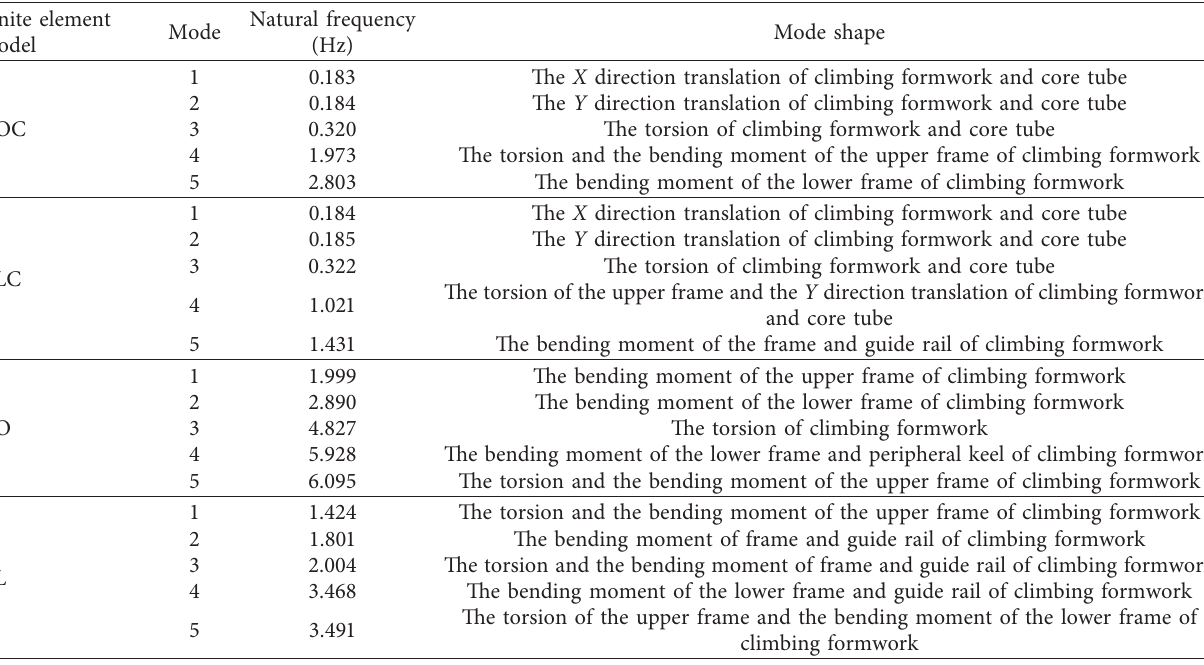
Table 6: Natural frequency and mode shape of the climbing formwork model.